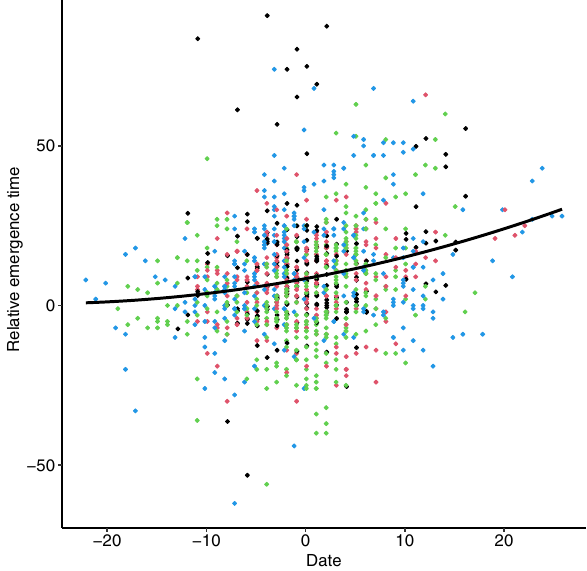
Figure 1. Date (mean-centred within years) positively affects relative emergence time (in minutes; negative = before sunrise, positive = after sunrise). Black = 2018, red = 2019, green = 2020, blue = 2021.